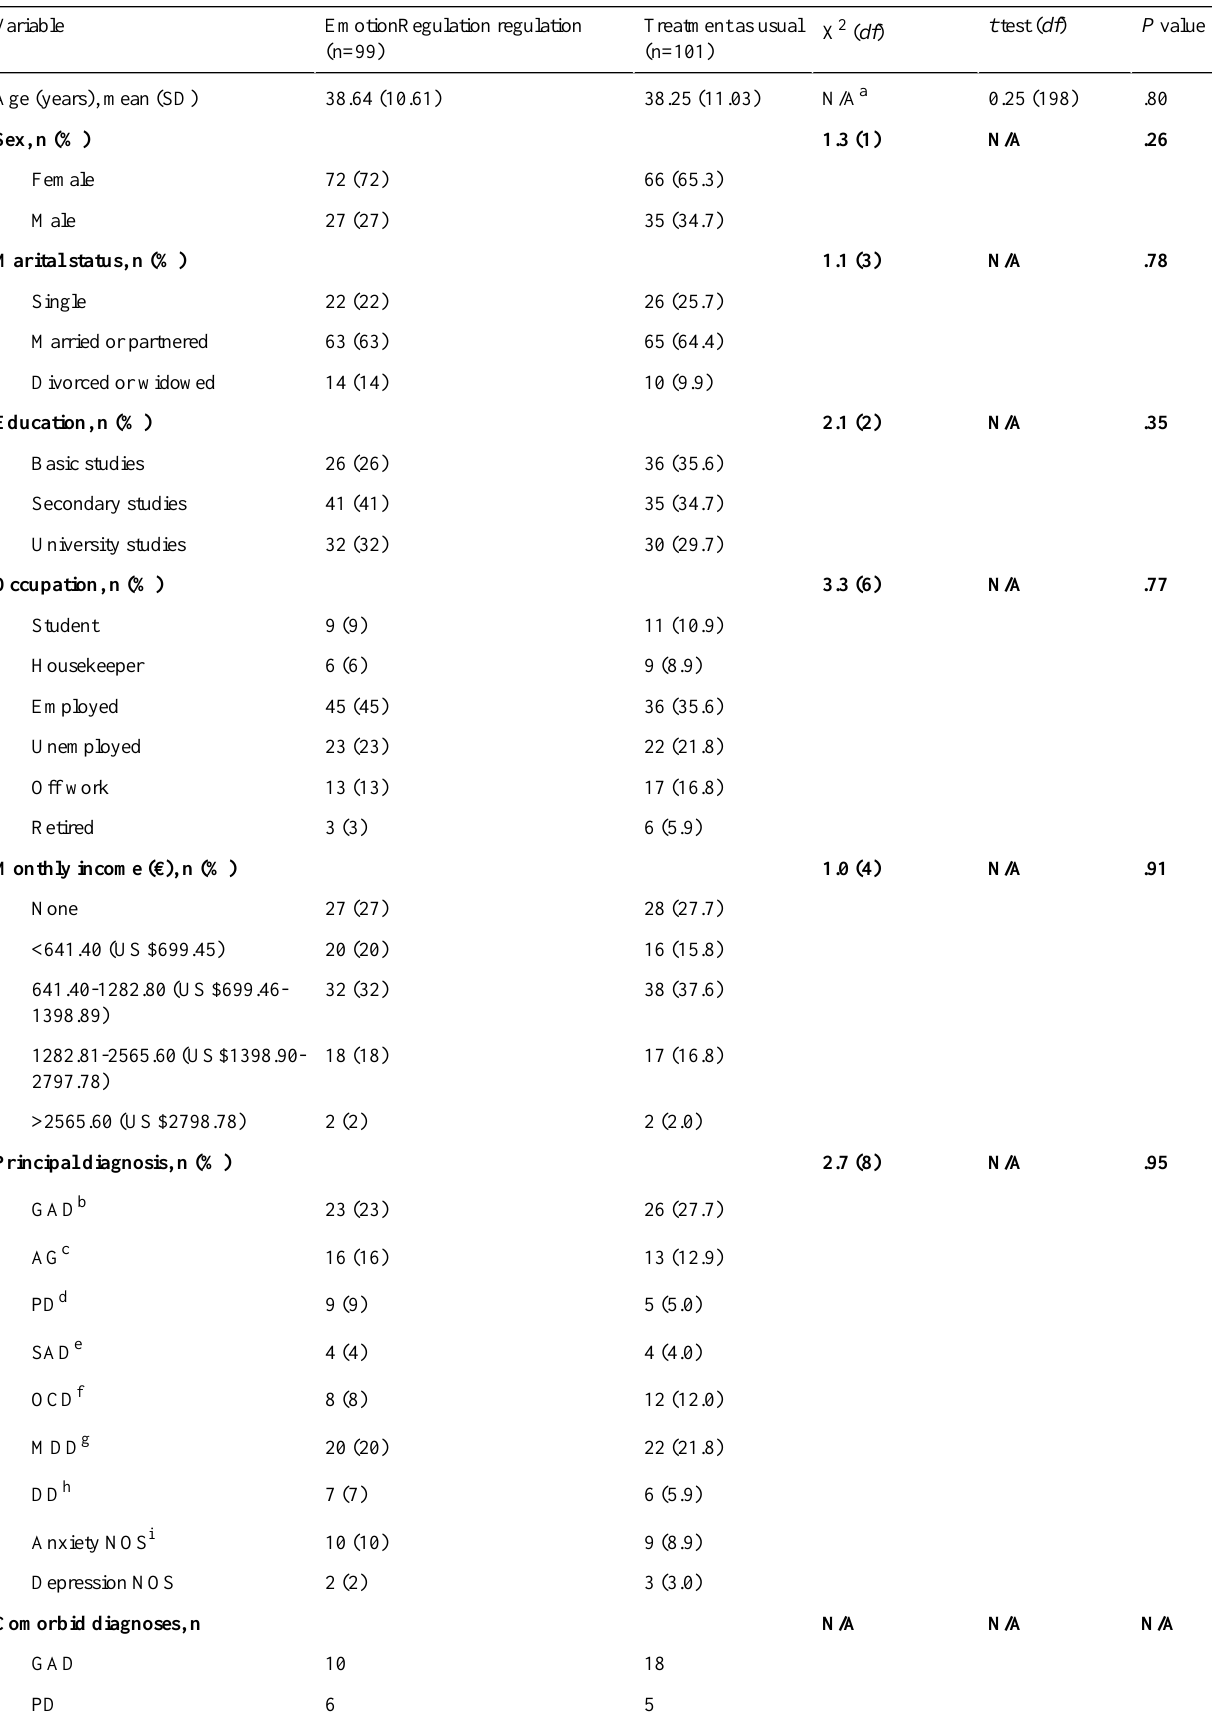
Table 2. Demographic and clinical characteristics of the sample at baseline